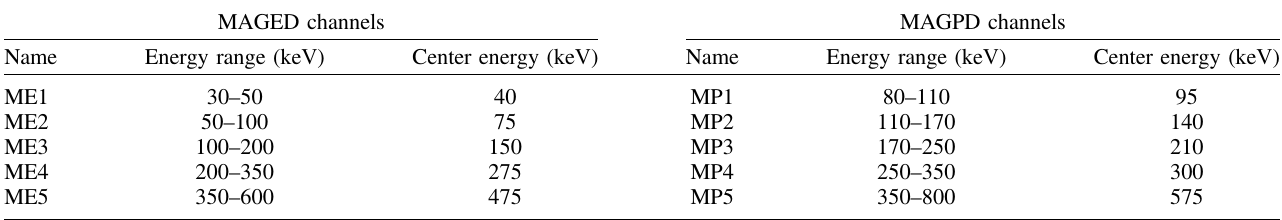
Table 1. MAGED and MAGPD channel names and energies (Hanser , 2011) .